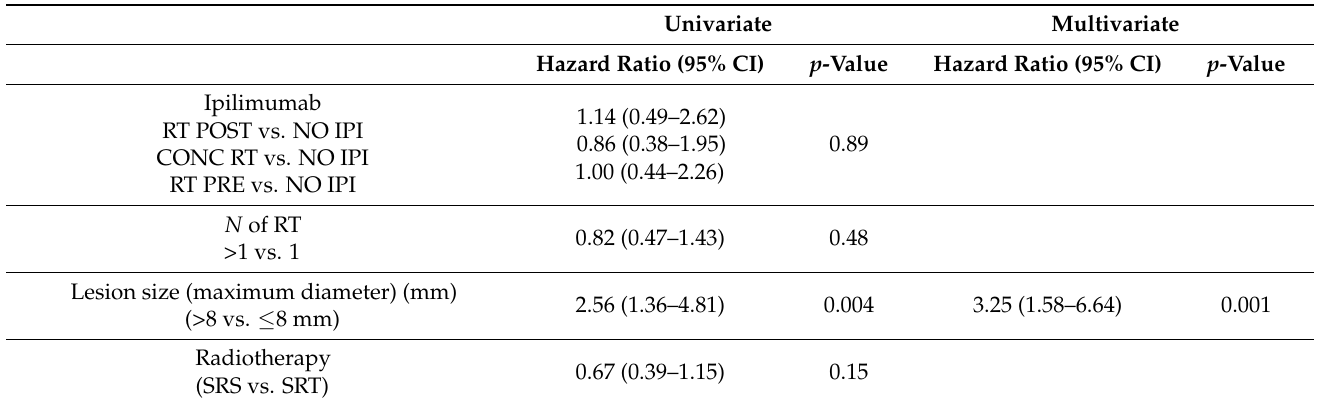
Table 4. Univariate and multivariate analysis for overall survival.